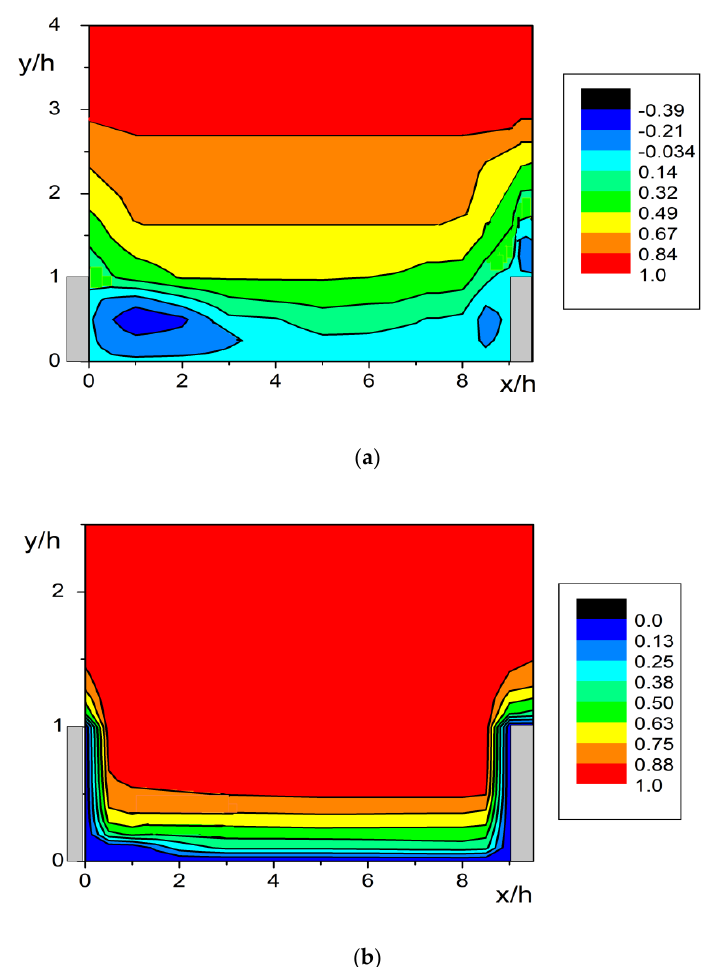
Figure 9. The contour plots of the mean streamwise velocity ( a ) and temperature ( b ). Re = 1.6 × 10 4 , d 1 = 15 μm, M L 1 = 0.05. d 1 = 15 µ m, M L 1 =